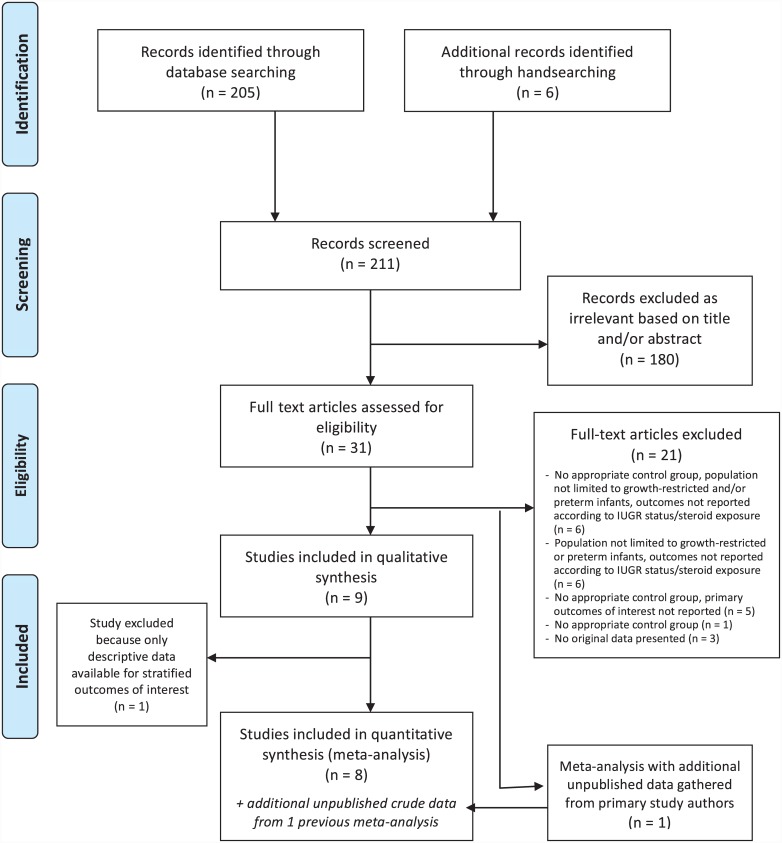
Flow diagram of search results and study selection for sub-question P4.